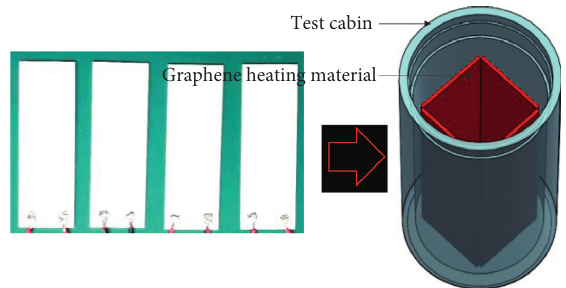
Figure 5: Graphene heating material in the heating water experiment.